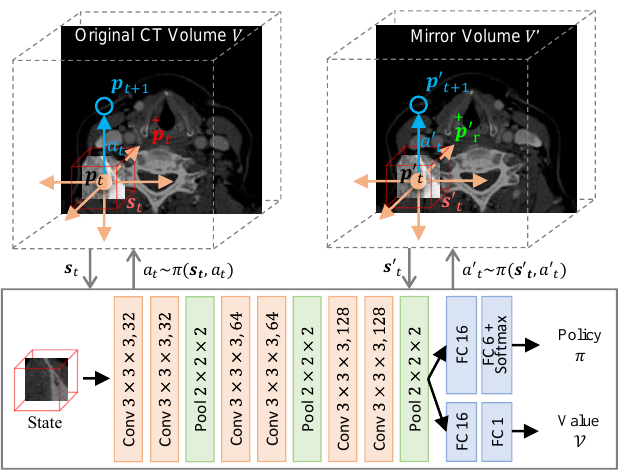
Figure 3. Proposed mirror environment. A single RL agent localizes the right fold in the original volume and left fold in the flipped